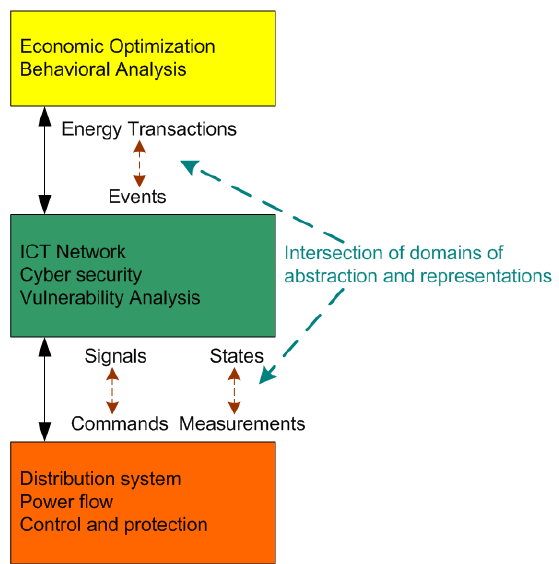
Figure 2. Illustration of semantic layer of a CPES co-simulation